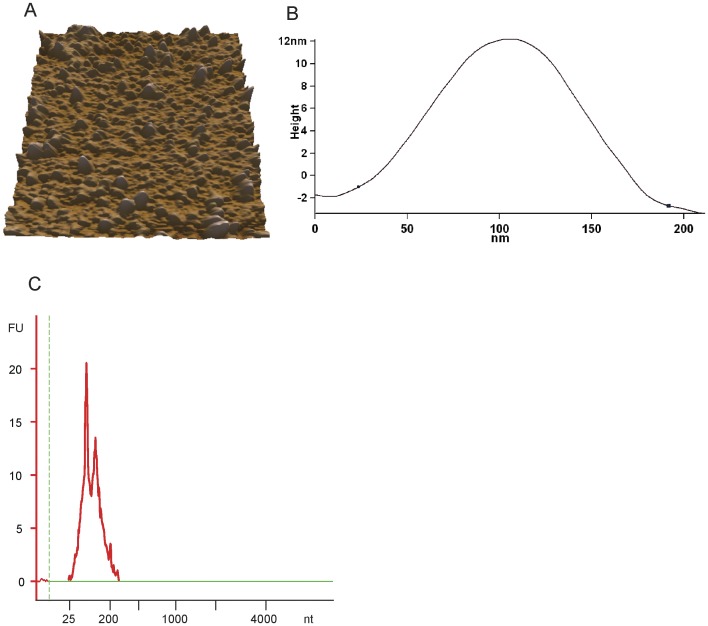
Evidence of miRNA-loaded exosomes in porcine breast milk.(A) 3D AFM image of isolated milk exosomes. (B) The line profile of AFM image for a milk exosome. X- and Y-axes are the width and height of a porcine milk exosome, respectively. (C) RNA from porcine breast milk exosomes was detected using Agilent Bioanalyzer 2100.